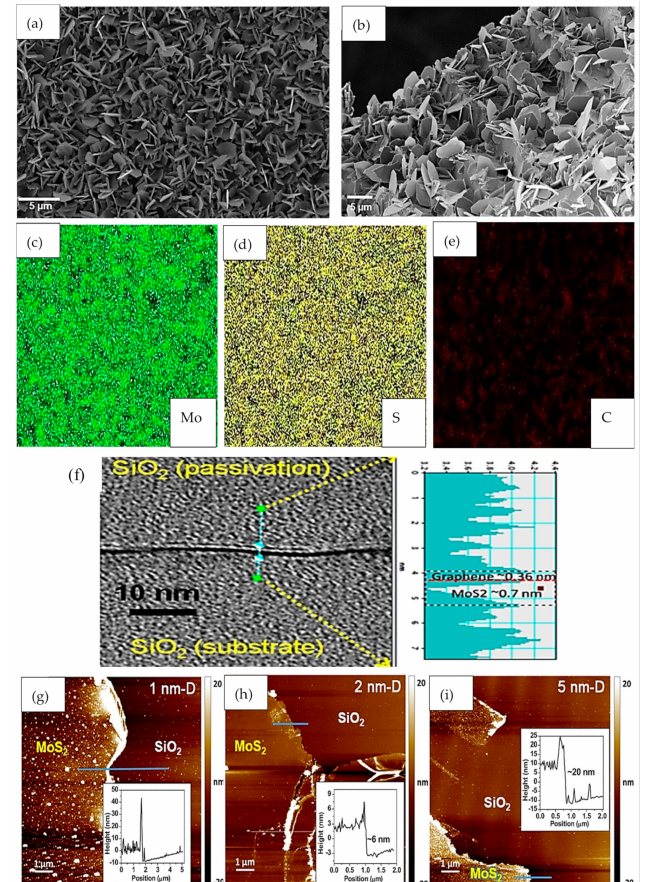
Figure 8. ( a , b ) Vertically grown MoS 2 nanosheet on graphene, ( c – e ) EDS elementary mapping of vertical MoS 2 (element of mapping is mentioned in the bottom right corner) (Republished with permission of Royal Society of Chemistry, from [59]; permission conveyed through Copyright Clear- ance Center, Inc., 2019), ( f ) high resolution TEM (HRTEM) image of graphene/heterostructures with thicknesses extracted from the intensity profile (Reproduced with permission from [32], Published by Springer Nature, 2014) and atomic force microscope (AFM) images of MoS 2 films on SiO 2 /Si substrate with pre-deposited Mo thicknesses of ( g ) 1 nm, ( h ) 2 nm and ( i ) 5 nm (Reprinted from [9], with permission from Elsevier,